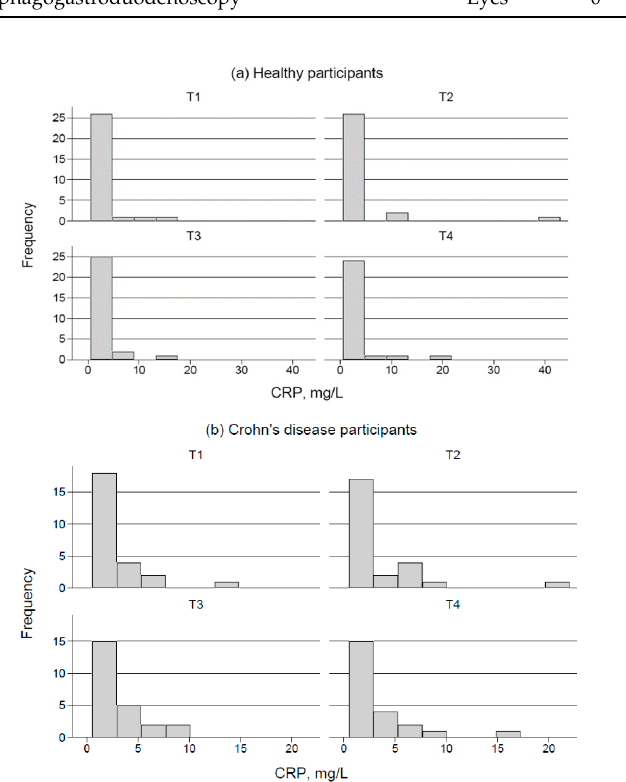
Figure A1. Distribution of C-reactive protein (CRP) measurements in the ( a ) healthy and ( b ) Crohn’s disease trials.